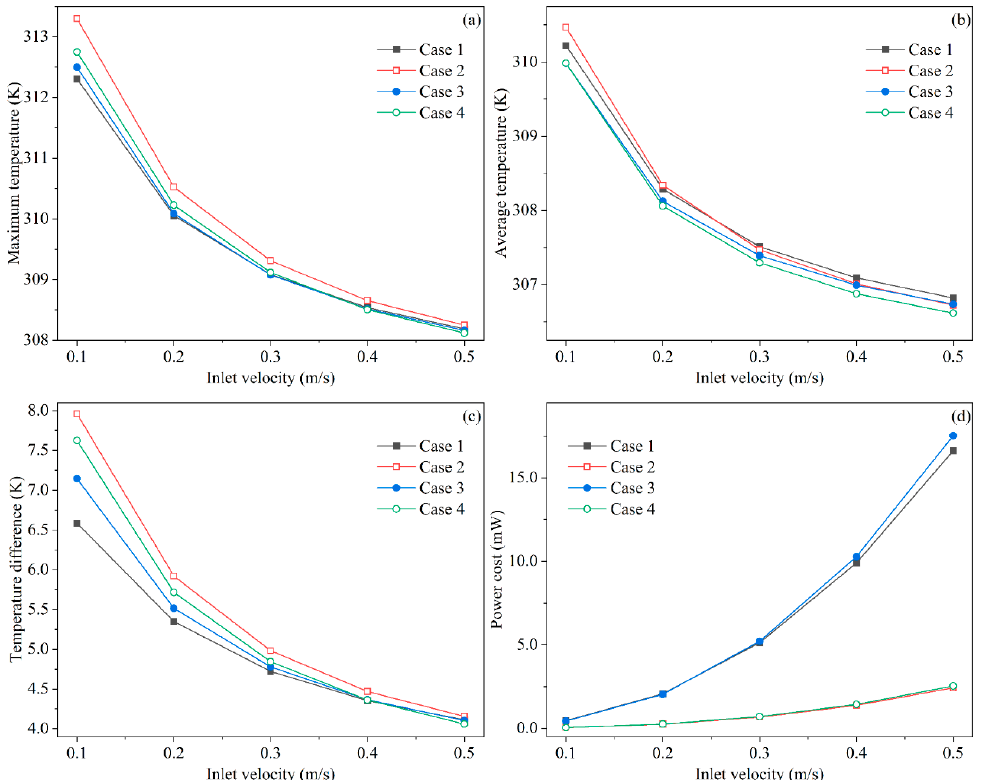
Figure 6. Thermal-hydraulic performance of Cases 1–4 with the variation of inlet flow velocity: ( a ) maximum battery temperature; ( b ) average battery temperature; ( c ) battery temperature difference, and ( d ) required power cost.